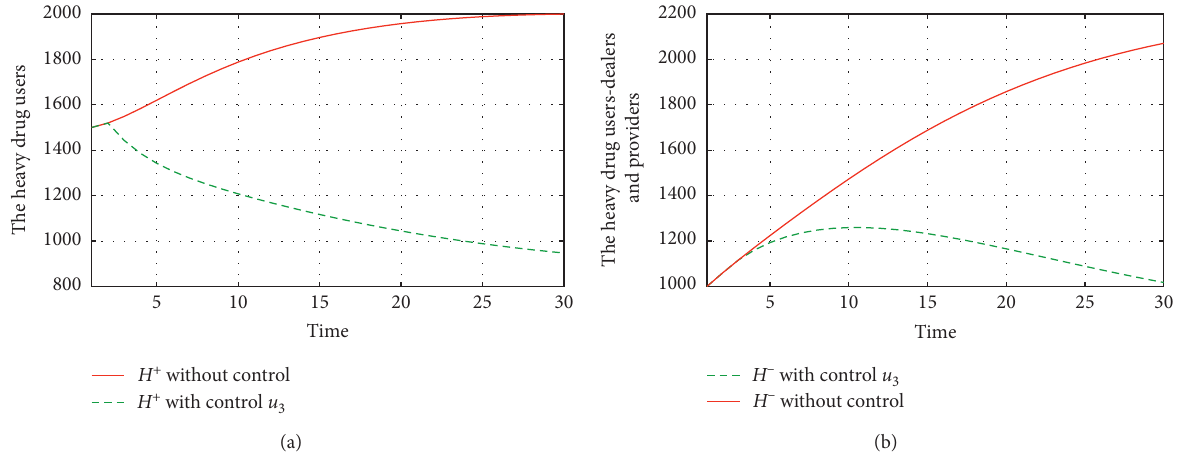
Figure 4: (a) The evolution of the H + with and without controls. (b) The evolution of the H − with and without